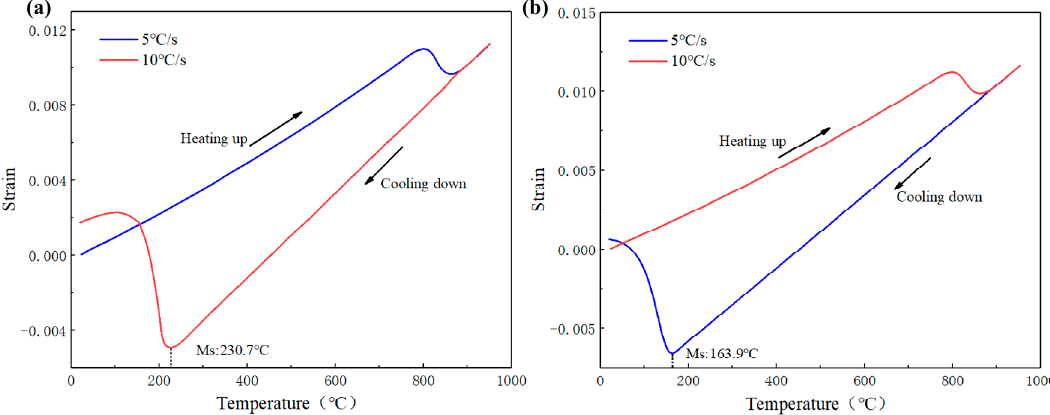
Figure 3. Dilatometric curves of different carbon content: ( a ) 0.5% carbon; ( b ) 0.8% carbon.